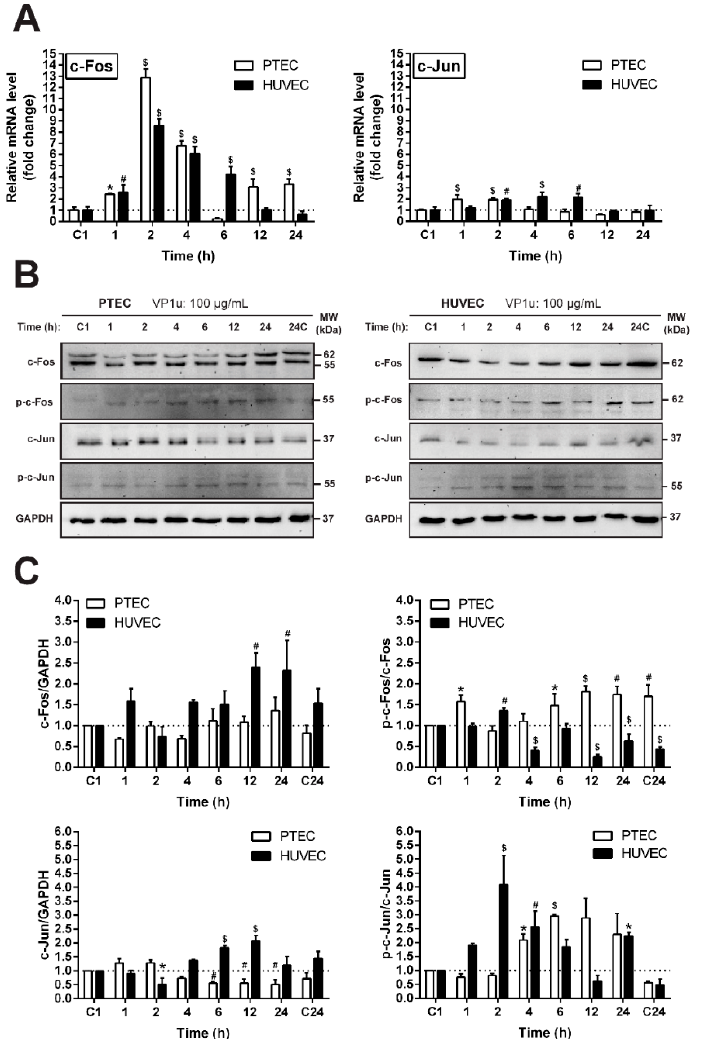
Figure 4. Evaluation of the activation protein-1 (AP-1) components (c-Fos/c-Jun) in EC after exposure to 100 µ g/mL VP1u. ( A ) RT-qPCR analysis of the c-Fos and c-Jun mRNA levels in EC at different time points. The data were normalized to GAPDH and presented as a fold change ± SD over the untreated control. ( B ) The abundance of c-Fos and c-Jun proteins in EC. ( C ) Quantification of the total and phosphorylated proteins at different times of VP1u exposure. The results are presented as mean ± SD. p ≤ 0.05 (*), p ≤ 0.01 (#), p ≤ 0.001 ($) vs. control (C1).